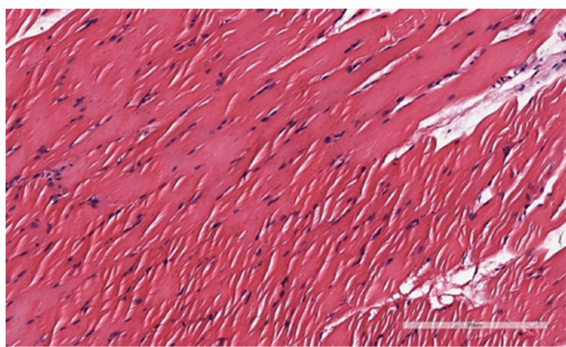
Figure 2. Oxytocin group m. pubocaudalis (PC) muscle.